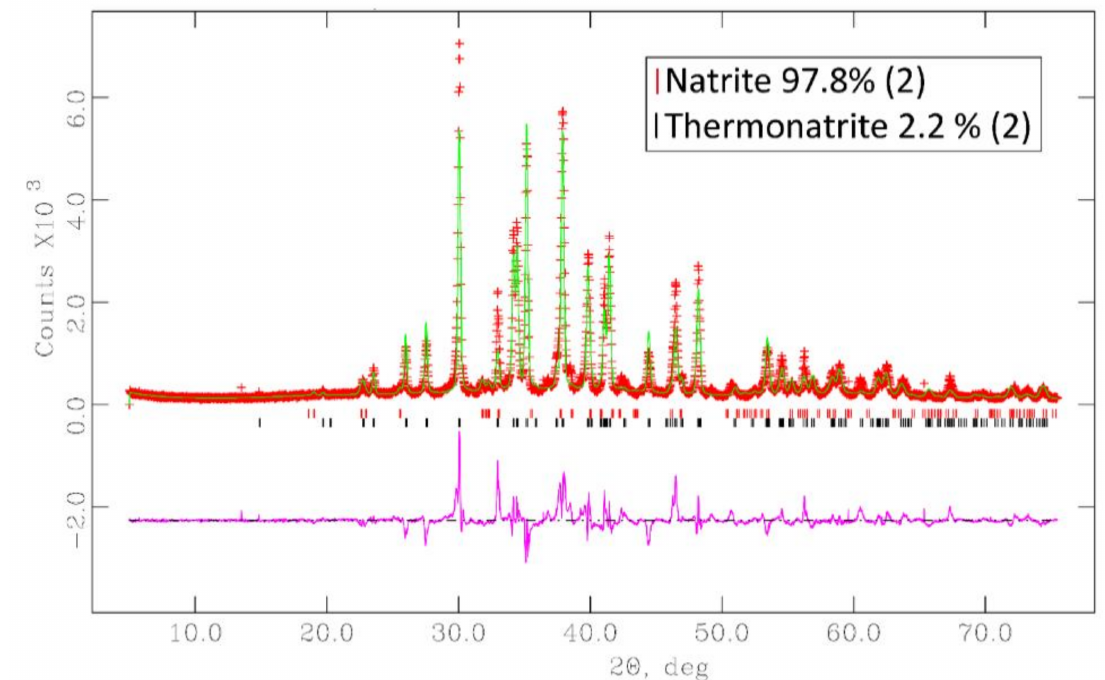
Figure 11. Room temperature X-ray powder diffraction pattern of trona after heating, refined by the Rietveld method [60] with Rp.